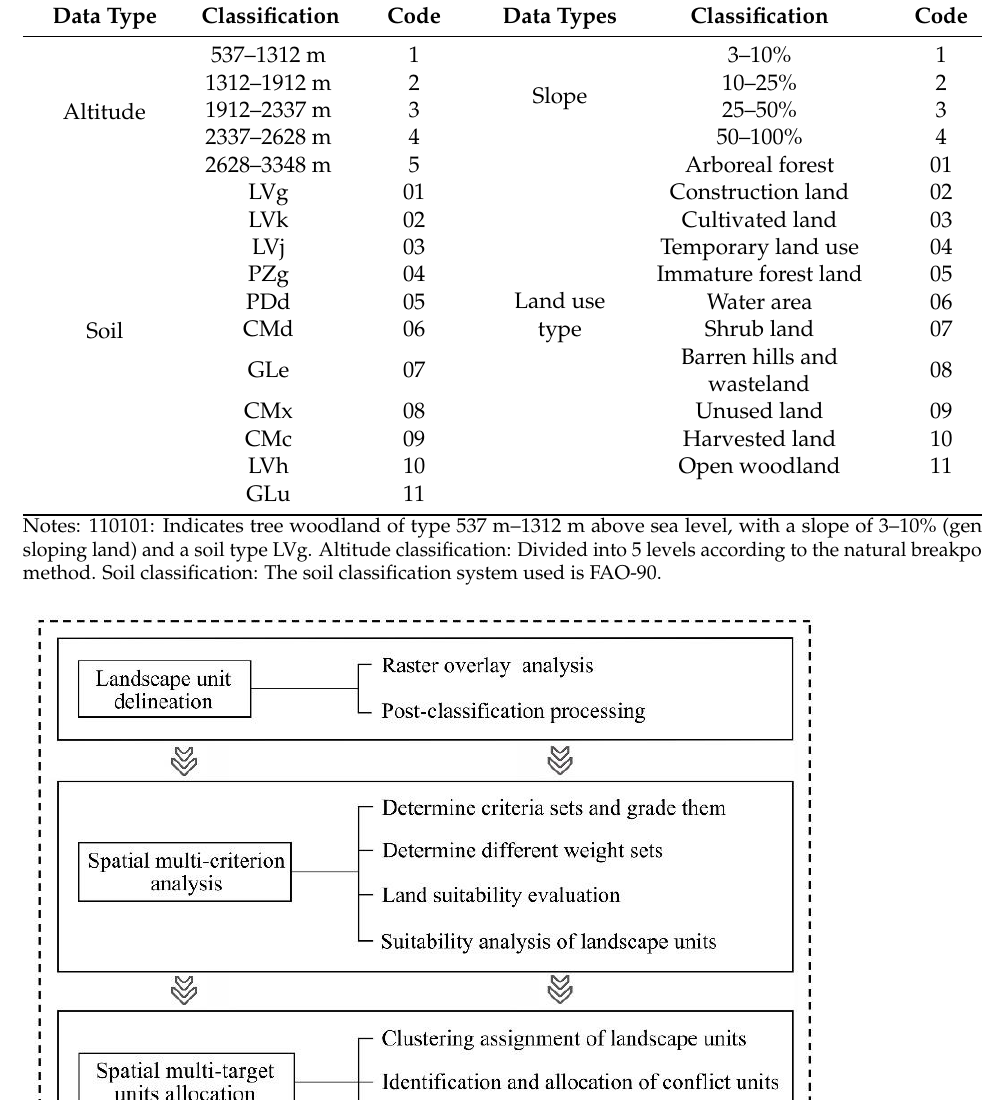
Table 1. Landscape unit attribute coding.